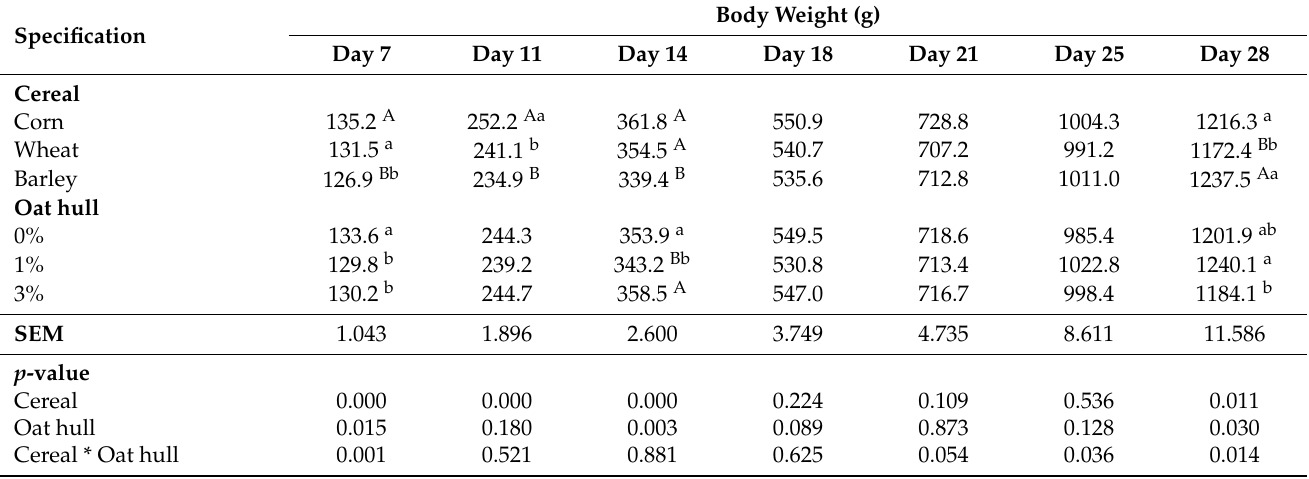
Table 3. Body weight of broiler